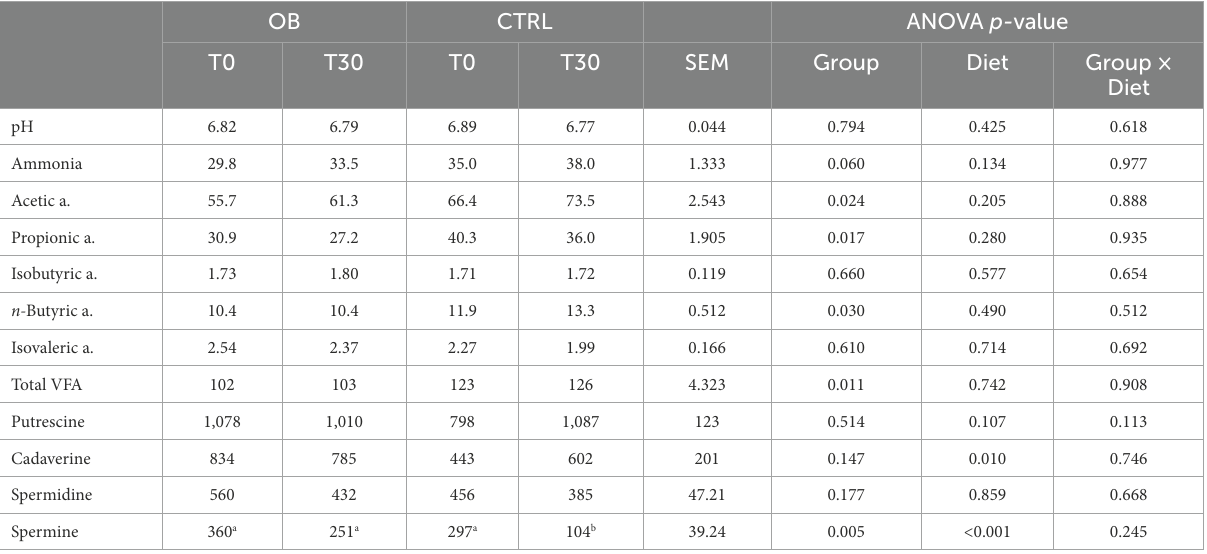
TABLE 2 Fecal pH values and concentrations of ammonia ( μ mol/g), volatile fatty acids ( μ mol/g) and biogenic amines (nmol/g) in feces of obese ( n = 16) and lean dogs ( n = 15) fed the same experimental diet, without caloric reduction, for 30 days (phase 1 of the study).